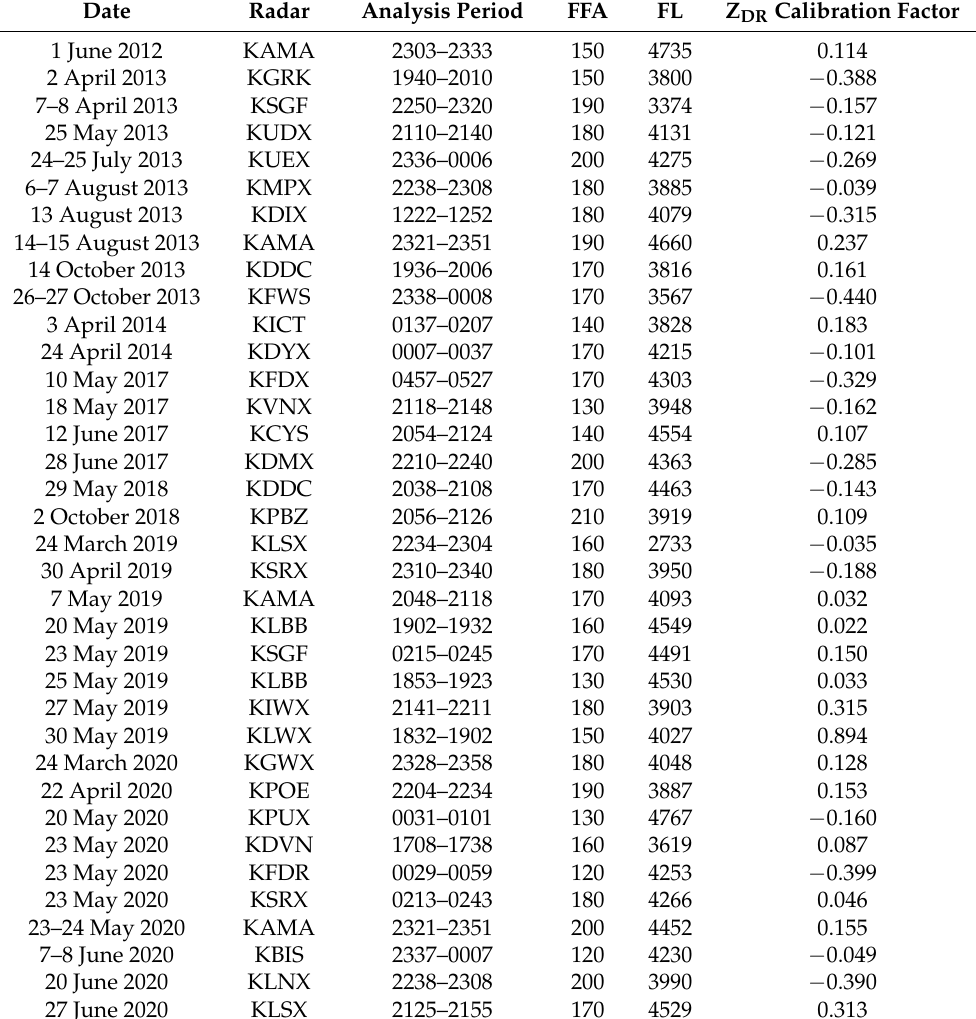
Table 2. The date, radar, analysis period (UTC), forward flank angle (FFA; degrees), freezing level (FL; meters), and Z DR calibration factor (dB) for each of the nontornadic cases included in the pre-TGF analysis. The end of the analysis period is the TGF